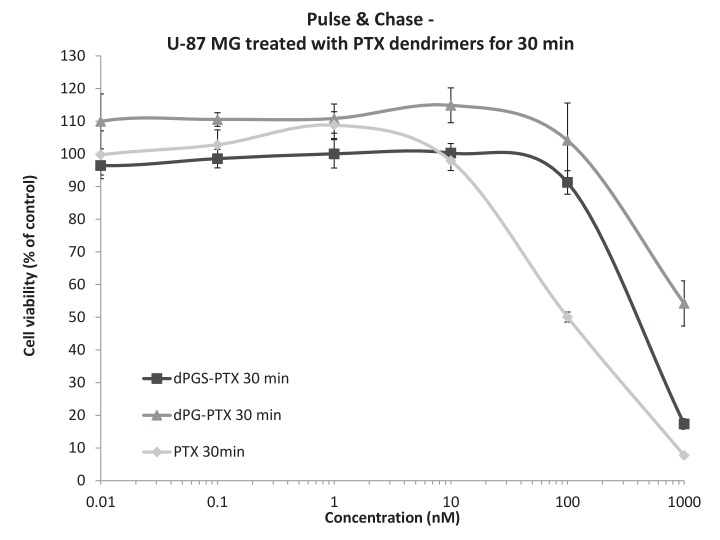
Differences in the in vitro activity of the dendritic conjugates are attributed to differences in their internalization kinetics.U-87 MG cells were incubated with serial concentrations of dPG-PTX, dPGS-PTX or free PTX for 30 min, washed, left to grow for additional 72 hr and analyzed for growth inhibition. Data represent mean ± s.d. of triplicate wells. Graph is representative of 3 individual experiments.10.7554/eLife.25281.014Figure 4—figure supplement 1—source data 1.Raw data of U-87 MG proliferation assay following short-term exposure to treatments.